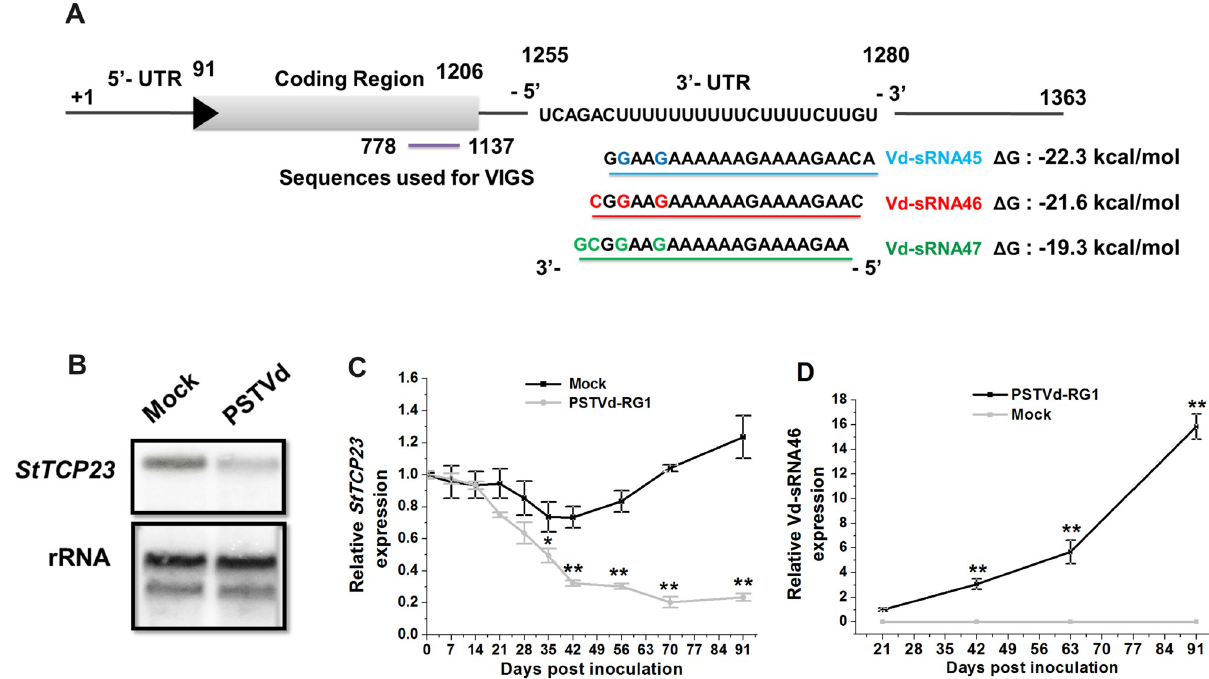
Fig 2. Targeting of StTCP23 mRNA for silencing by small interfering (si) RNAs derived from PSTVd-RG1. (A) Schematic diagram of the mRNA encoding StTCP23 . Complementarity between a target sequence located in the 3´ UTR and small RNAs derived from the PSTVd-RG1 genome and beginning at nt position 45 (blue line), 46 (red line), or 47 (green line) are shown. The PairFold online tool was used to predict the minimum free energy of the resulting RNA duplexes. Purple line, portion of the StTCP23 coding sequence used for VIGS. (B, C) Effects of PSTVd-RG1 infection on StTCP23 mRNA levels at different times post inoculation. Panel B, northern blot analysis of total leaf RNA extracted at 91 dpi, rRNA was used an internal loading control. Panel C, RT-qPCR analysis of the same series of RNA samples used to monitor PSTVd-RG1 replication (see Fig 1B). (D) Vd- sRNA46 expression profile in different development stage of PSTVd-RG1-infected